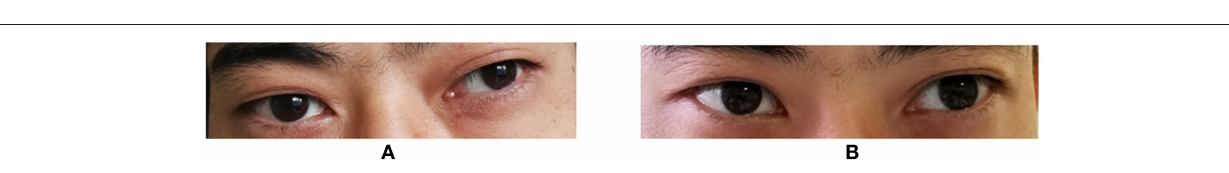
FIGURE 2 | Eyelid symptoms after cessation of pyridostigmine bromide therapy. (A) At 1 month after cessation of therapy (Dec. 2017). (B) At 3 months after cessation of therapy (Feb. 2018). At both time points, the left eyelid was nearly unaffected, showing only mild